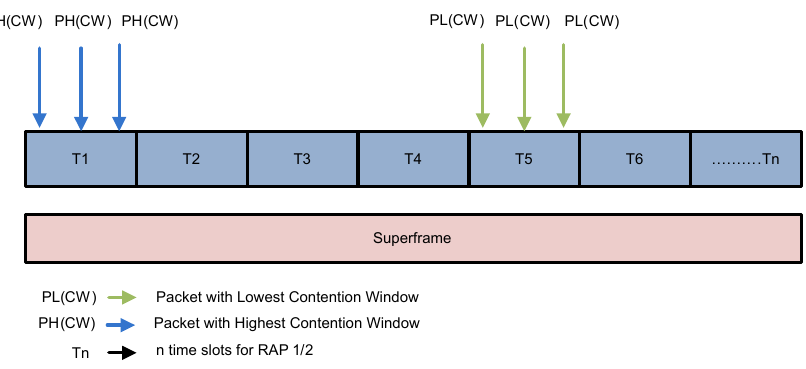
Figure 6. Packet collision scenario in CW assisted